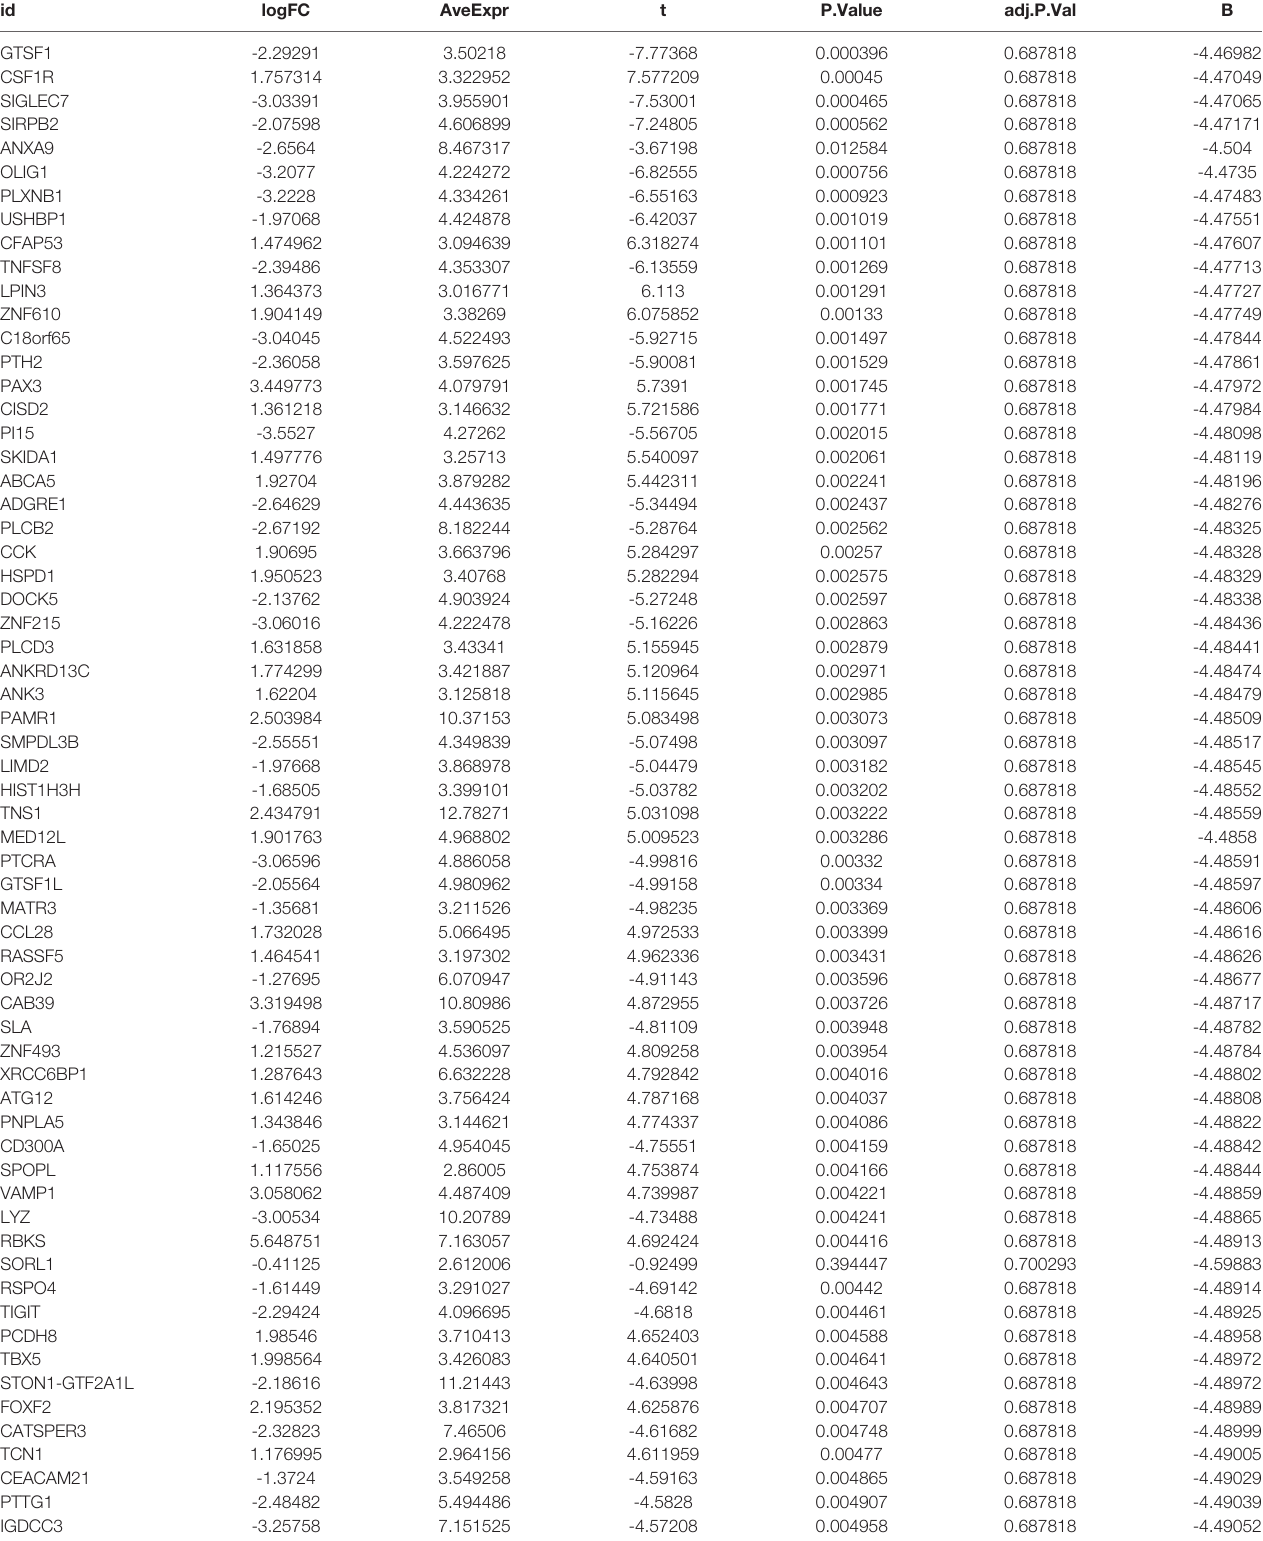
TABLE 3 | List of differentially expressed genes by high-throughput